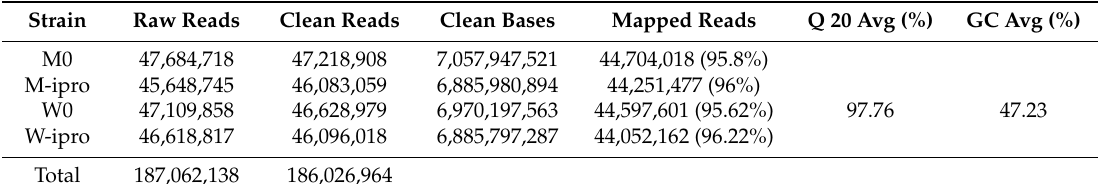
Table 1. Details of raw and clean data of twelve transcriptomes of B. cinerea and the reference genomes.